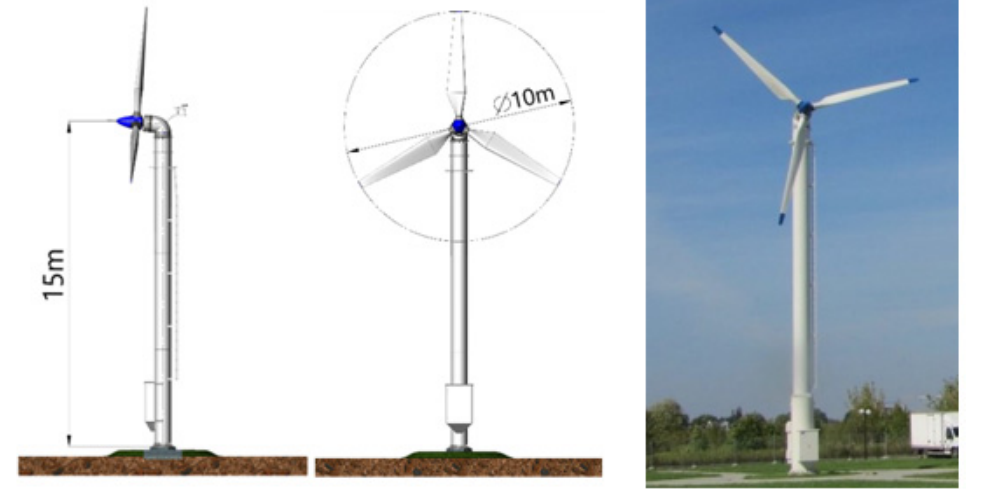
Figure 3. Analyzed wind turbine, side and front views and photograph [28].